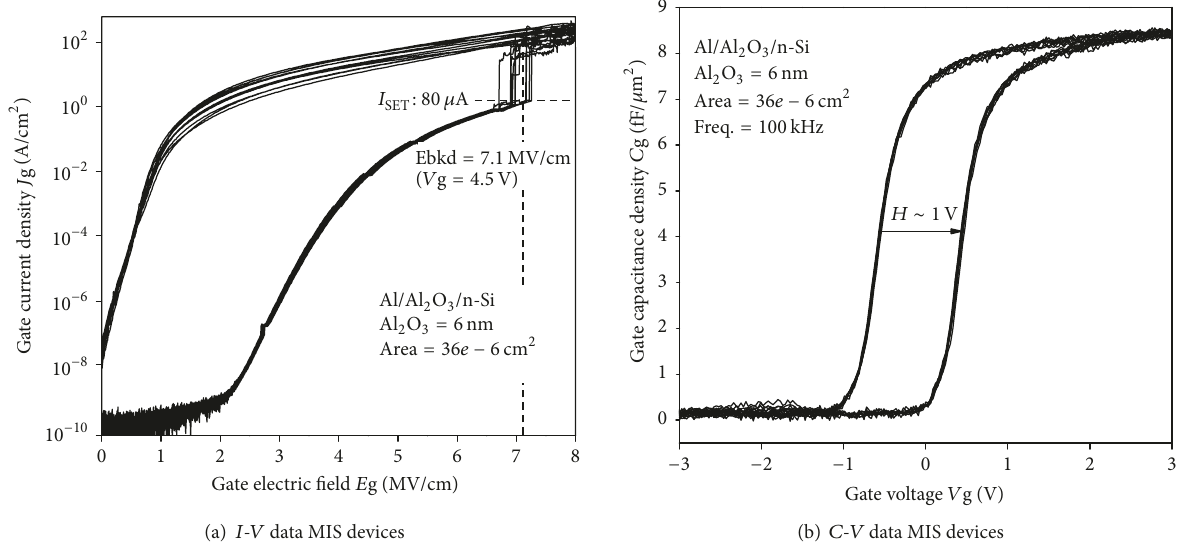
Figure 3: Electrical characteristics of MIS devices based on thinner Al 2 O 3 = 6nm and without thermal annealing. Outstanding uniformity is observed for both (a) 𝐼 - 𝑉 and (b) 𝐶 - 𝑉 data after testing at least 15 different MIS devices for each measurement. This confirms the good quality of ALD method for deposition of thin Al 2 O 3